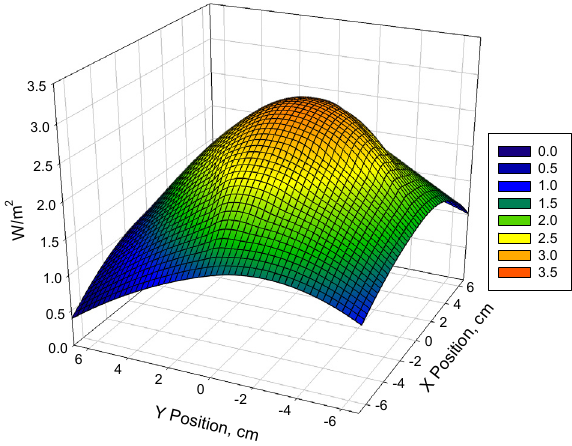
Figure 2. The UVC-LED system’s radiation distribution.